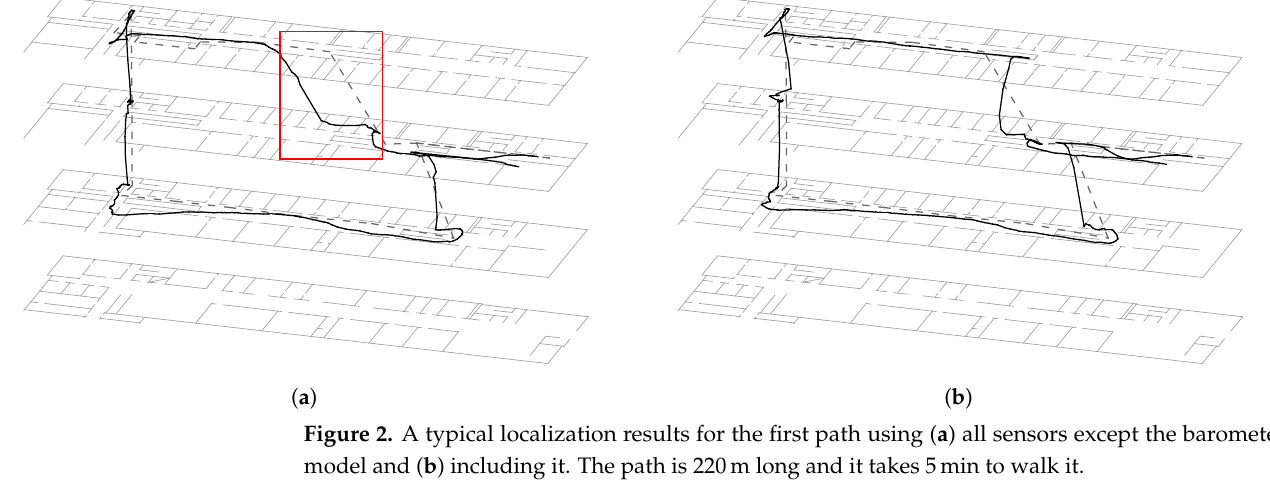
Figure 2. A typical localization results for the first path using ( a ) all sensors except the barometer model and ( b ) including it. The path is 220m long and it takes 5min to walk